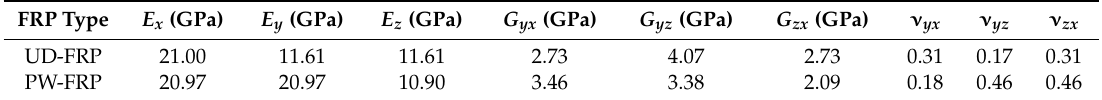
Table 1. Material properties of unidirectional fiber reinforced plastic (UD-FRP) and plain weave fiber reinforced plastic (PW-FRP).